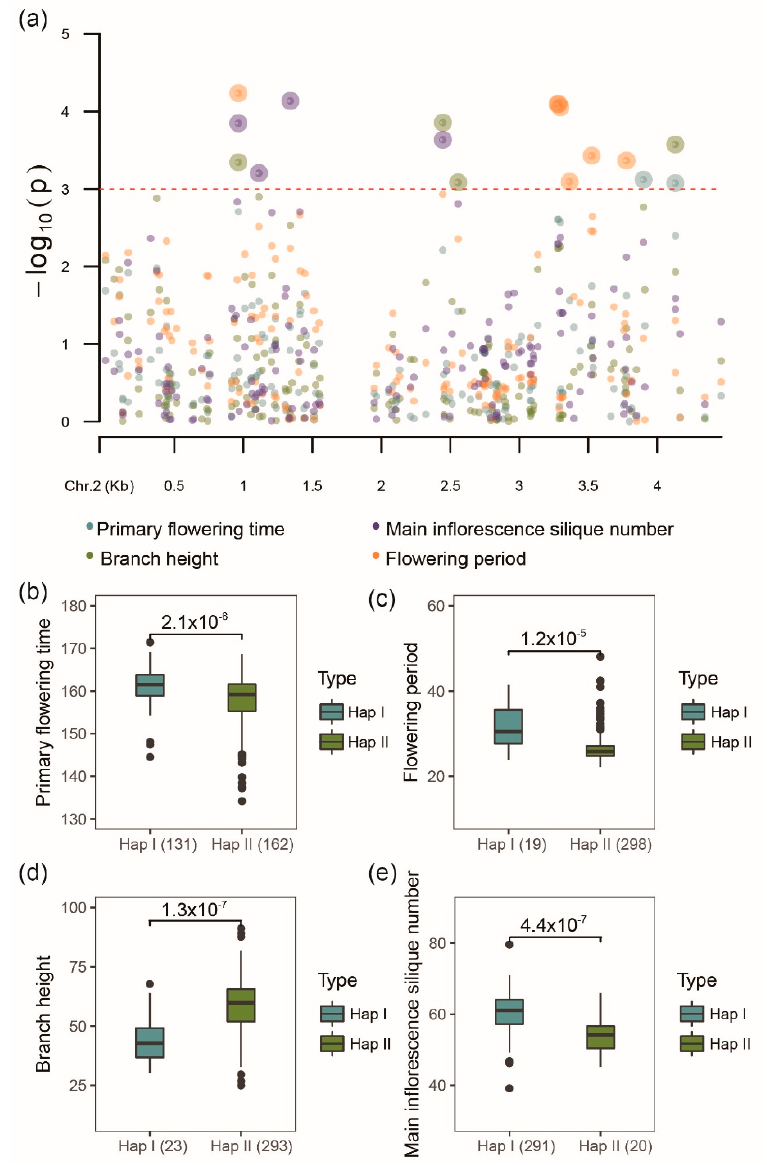
Figure 9. Association analysis of genetic variations in BnaA02g12100D in 324 worldwide collections of B. napus population with several agronomic traits. ( a ) Manhattan plot of BnaA02g12100D with primary flowering time, flowering period, branch height and main inflorescence silique number ( p < 0.001). ( b – e ) The haplotype analysis of BnaA02g12100D genetic variation for primary flowering time, flowering period, branch height and main inflorescence silique number.